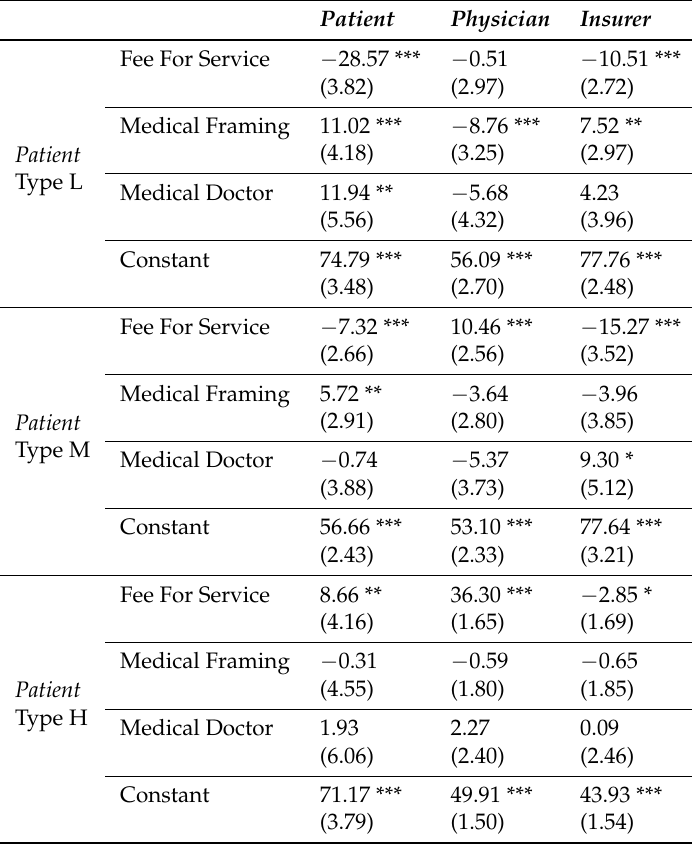
Table 11. Regression results—payoff for different participants by patient